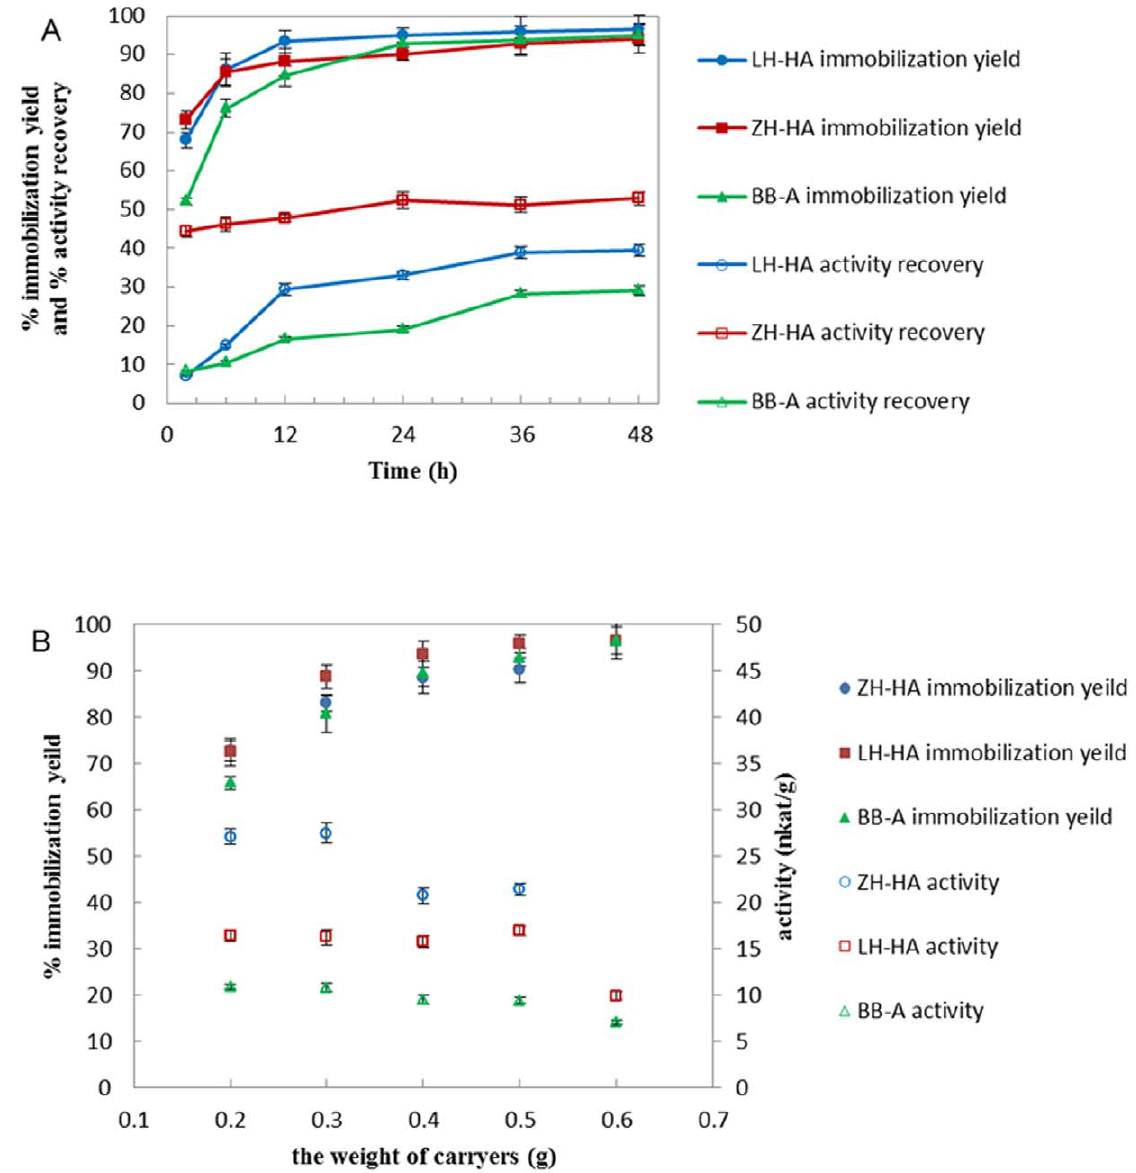
Figure 2. In situ immobilization of papain on aminated supports. (A) The immobilization course: the experiment was conducted by incubating 0.5 g supports in 5 ml enzyme solutions at 25 u C, 200 rpm. (B) Effect of supports input amount on immobilization: the experiment was conducted by incubating different weight of supports in 5 ml enzyme solutions at 25 u C, 200 rpm.